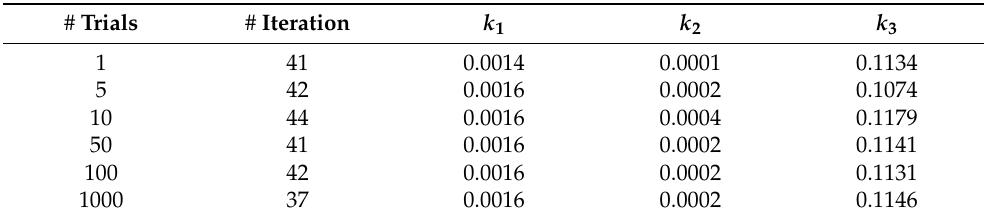
Table 6. Average values of the parameters obtained using the Nelder–Mead algorithm as a function of the number of trials and the number of iteration steps. The original values of parameters are k 1 = 0.0017, k 2 = 0.0001, and k 3 =